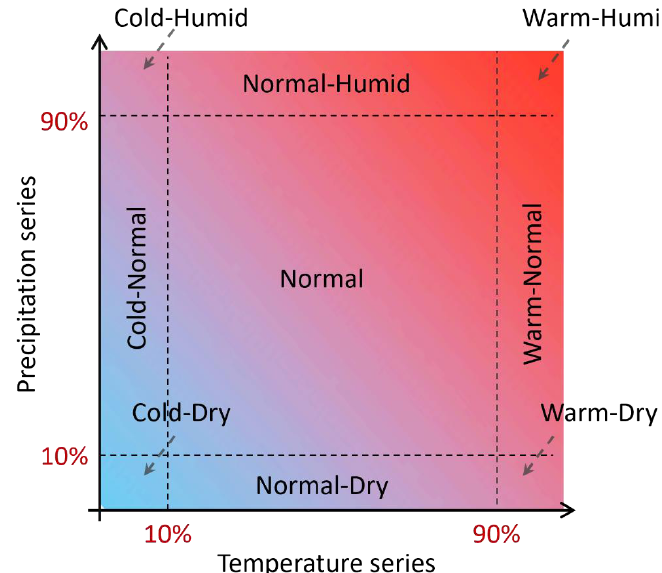
Figure 2. Classification of normal climate and climate extremes.